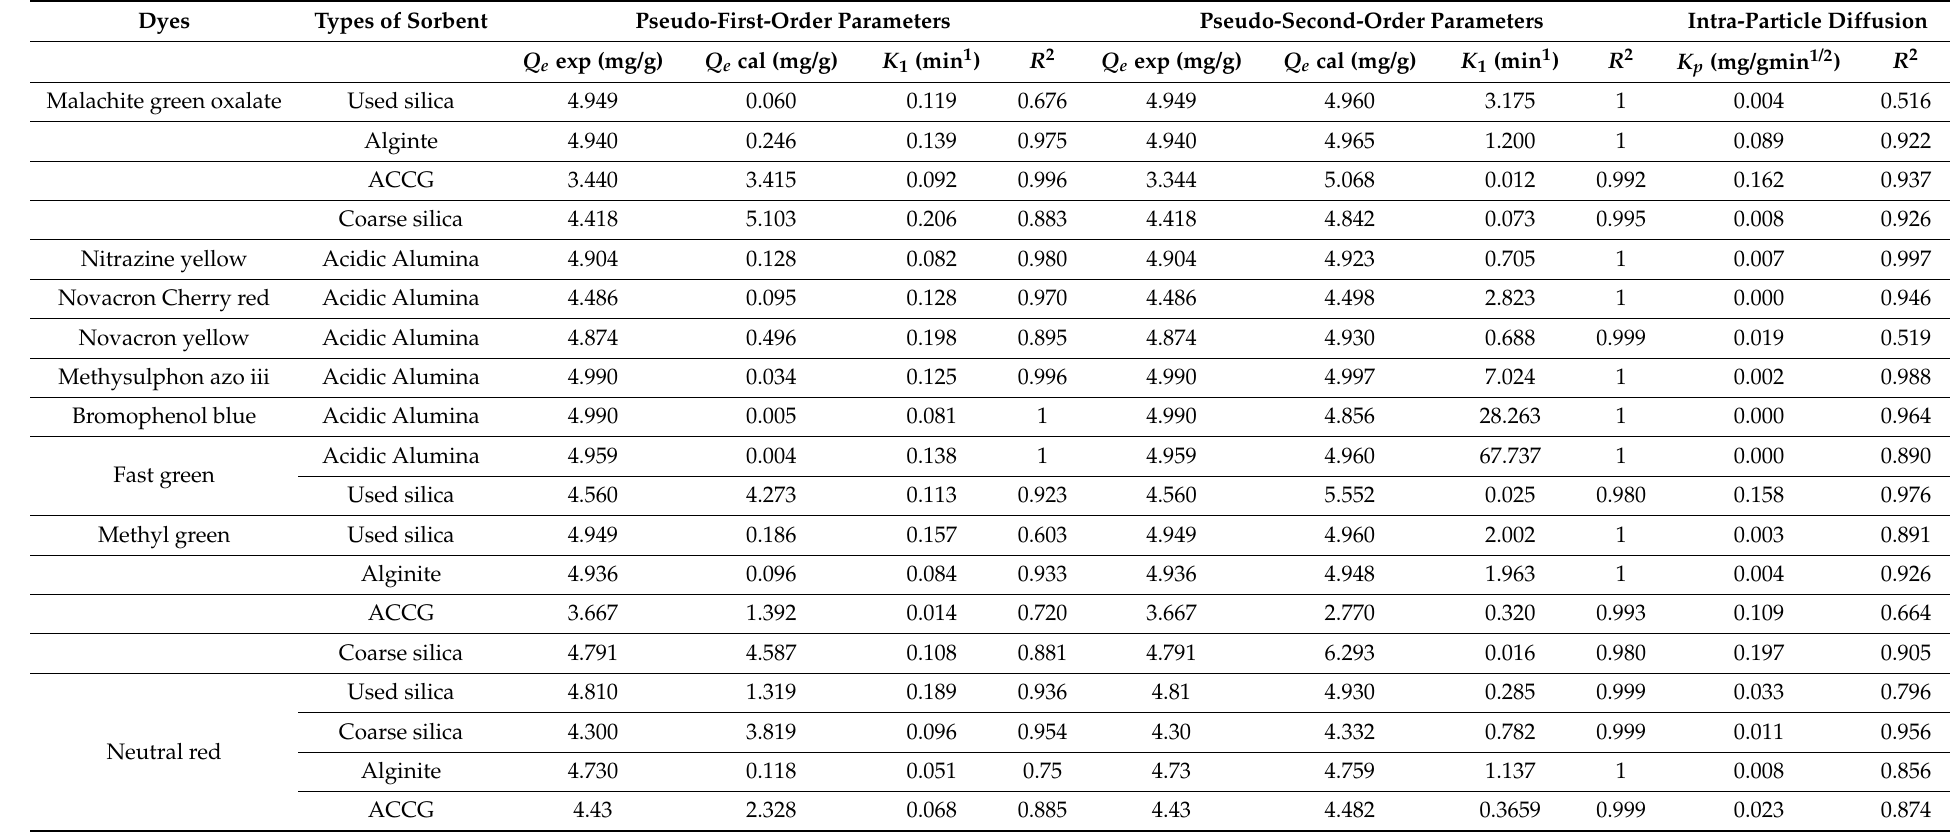
Table 5. Kinetic parameters for the adsorption isotherm of dyes for various